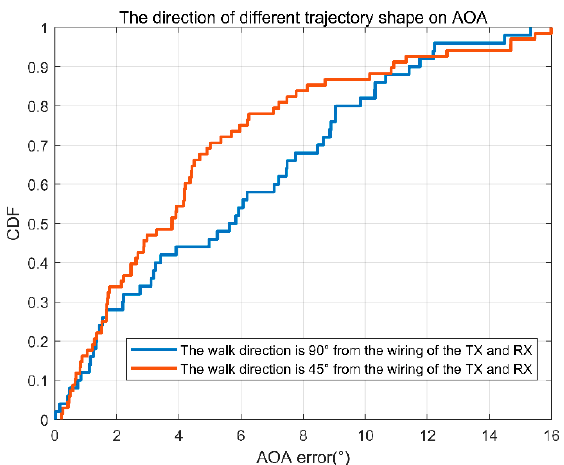
Figure 18. AOA error accumulation diagram of two different directions of motion. (6) Different walking distances.